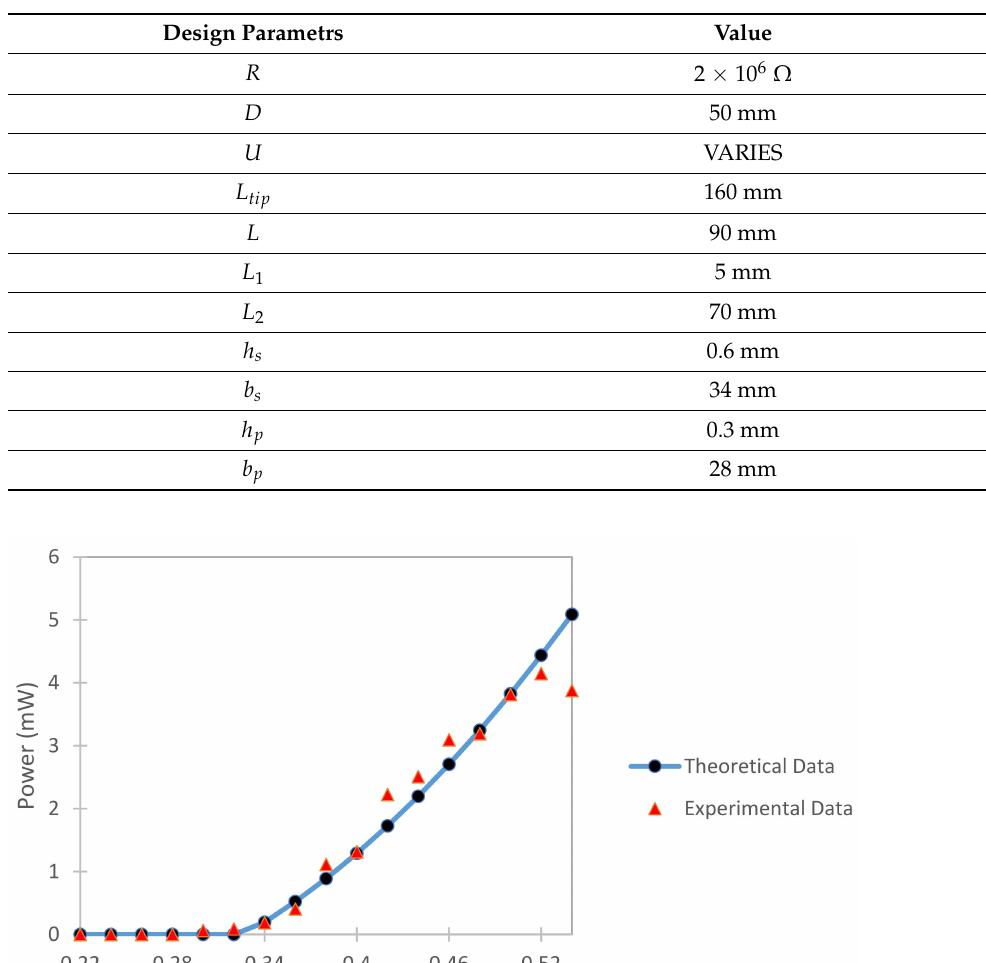
Table 1. Values of Design Parameters Used in Experimental Setup [30].